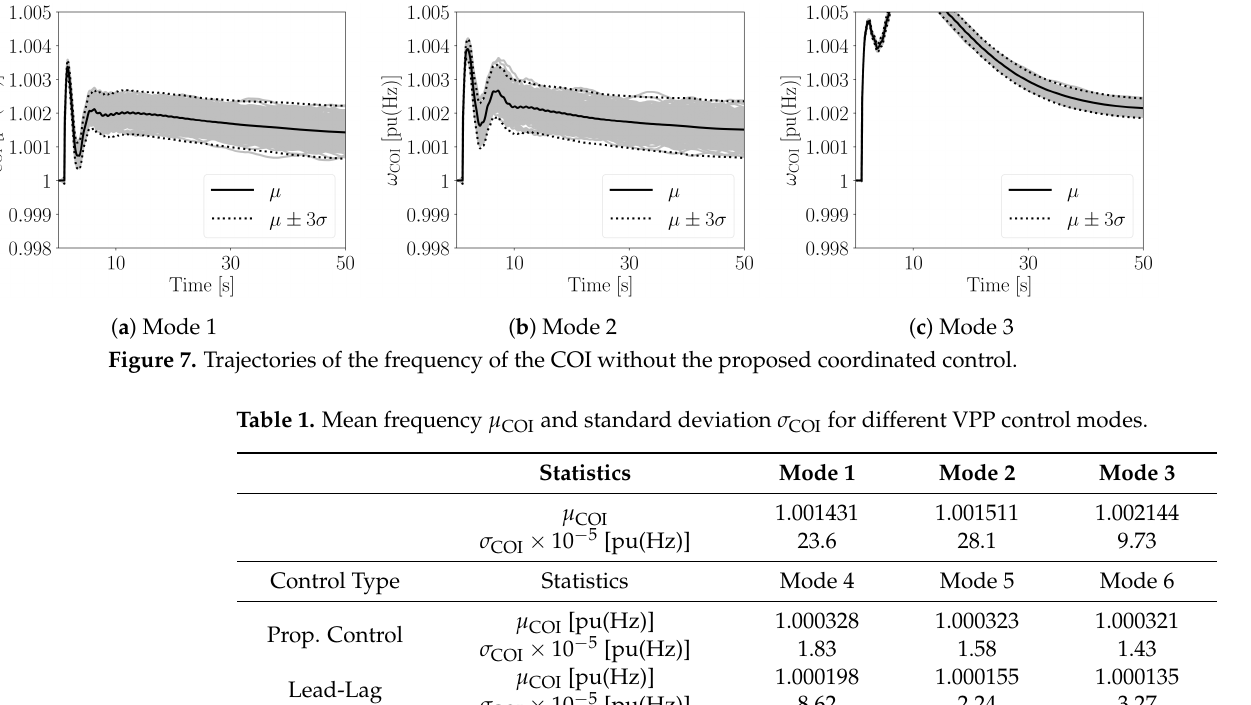
Figure 6. Trajectories of the frequency of the Center of Inertia (COI) without VPP frequency control and without ESS. The mean and the standard deviation of the frequency at t = 50 s are µ COI = 1.002 pu(Hz) and σ COI = 6.16 · 10 − 5 pu(Hz), respectively.